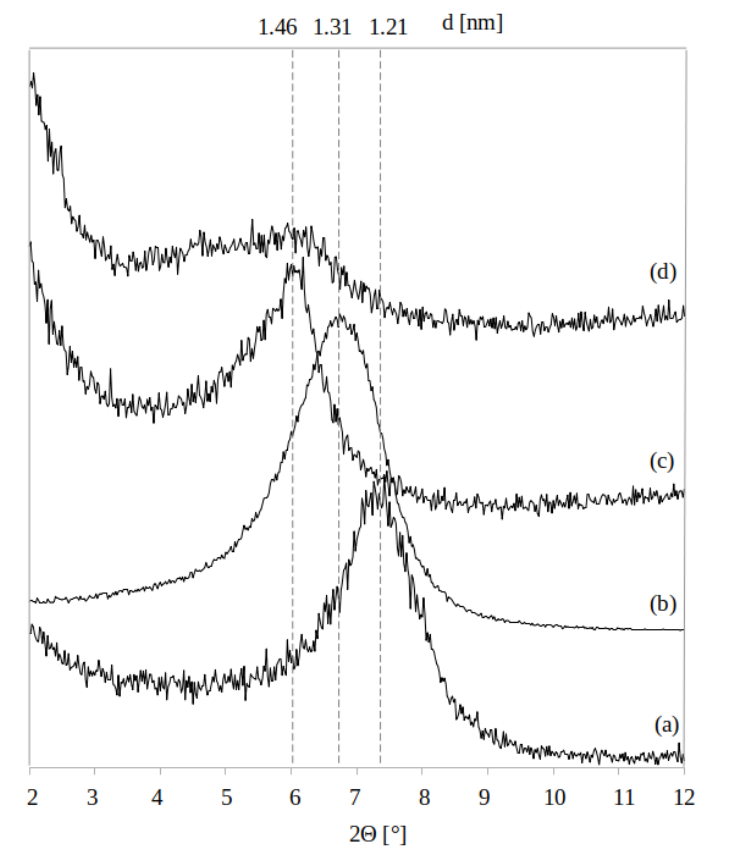
Figure 3. XRD diffractograms of ( a ) MMT powder, ( b ) film obtained from the MMTD, ( c ) SB-MMT film, ( d ) CSB-MMT